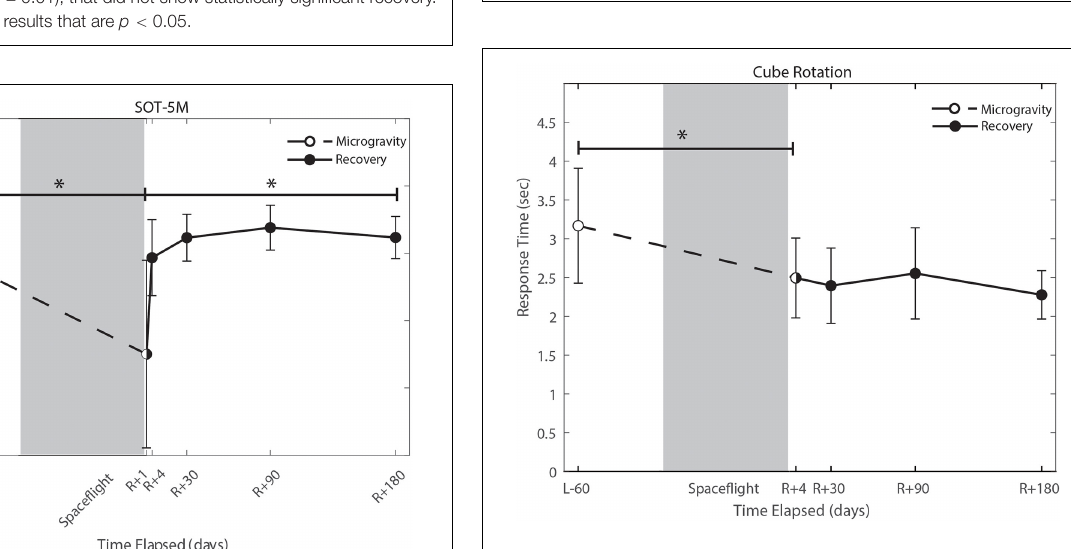
FIGURE 6 | Cube rotation performance changes from pre- to post-flight and post-flight recovery. Subject’s response time decreased significantly ( p = 0.004). *Indicates statistical results that are p < 0.05. ( Table 4 ) on the bimanual Purdue Pegboard Test ( p = 0.016; Figure 5 ), FMT ( p = 0.0001; Figure 2 ) and the